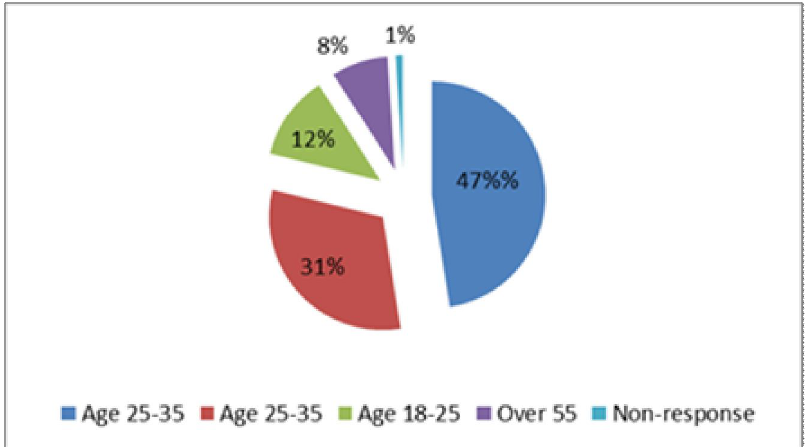
Figure 2: Age Analysis of the